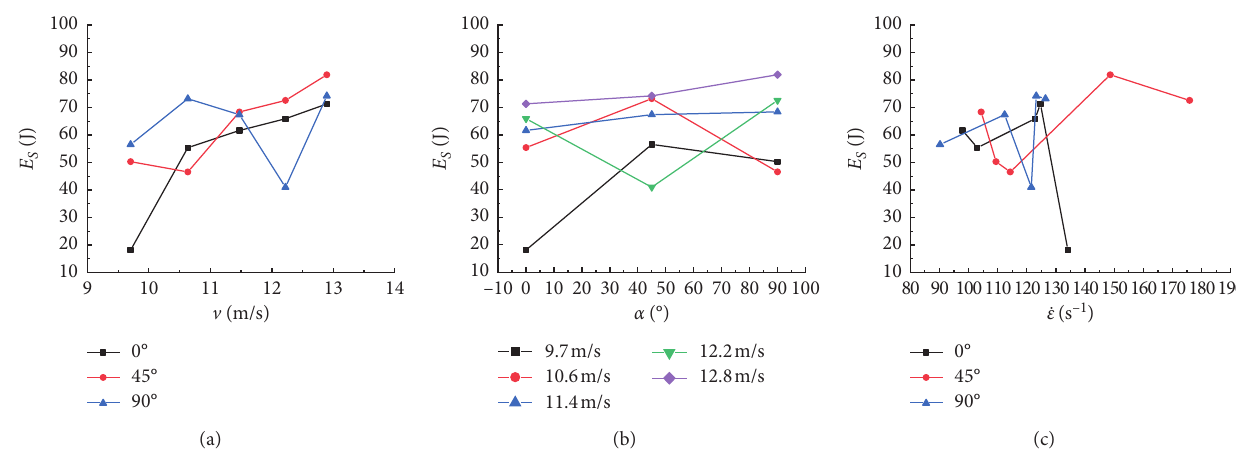
Figure 15: Relationship curves between absorbed energy and loading rate, prefabricated fracture angle, and strain rate. 0.100.150.200.250.300.350.400.450.500.550.60 ω